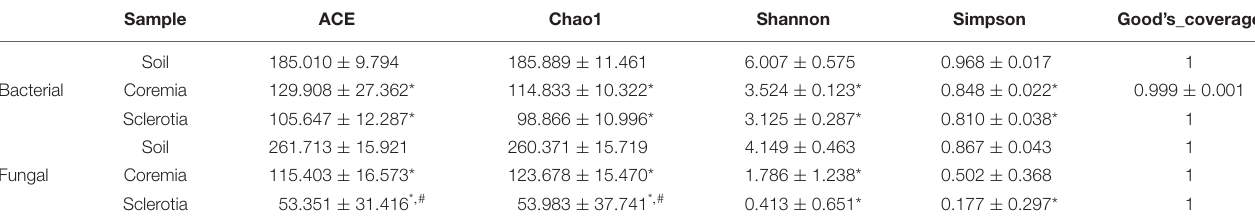
TABLE 2 | Alpha-diversity indices of bacterial and fungal communities in different samples.